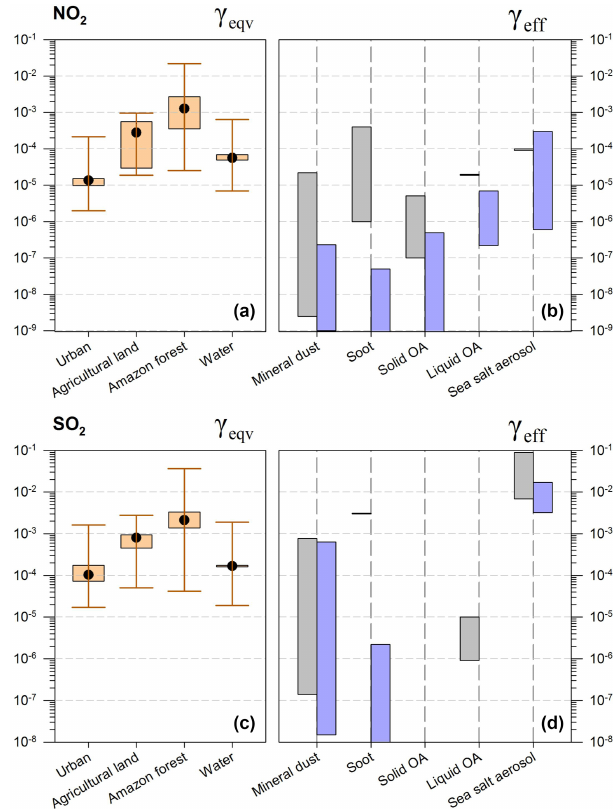
Figure 4. Uptake coefficients ( γ eqv , a, c ; γ eff , b, d ) for NO 2 and SO 2 on different ground types and